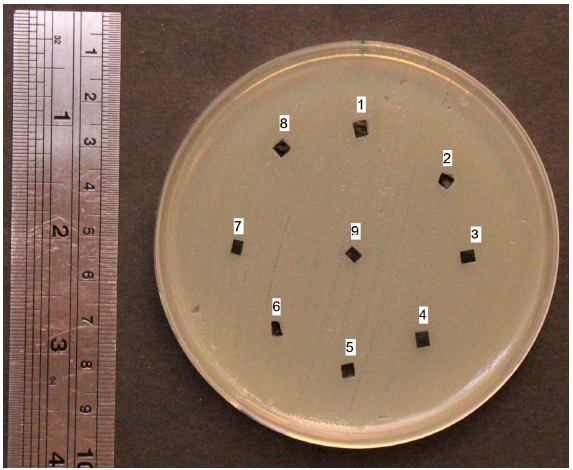
Figure 3. Results for PPy-gelatin actuator disk diffusion test of E. coli assay. Positions: 1 —[Ch][Ib], 2 —[Ch][Iv], 3 —[EMIM][FSI], 4 —[Ch][Mal], 5 —[Ch][Ac], 6 —[Ch][2mb], 7 —[EMIM][OTf], 8 —[Ch][Glu],